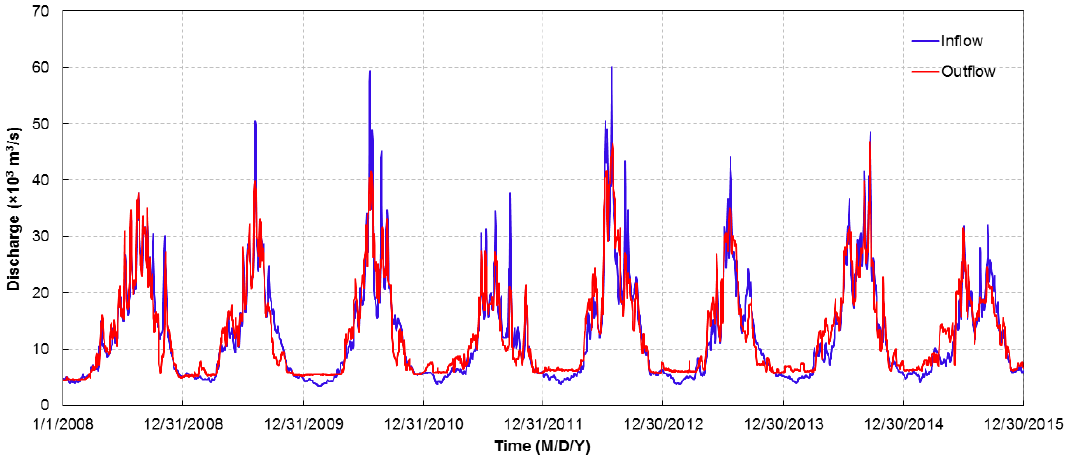
Figure 2. Inflow and outflow process of the Three Gorges Reservoir (TGR) from 2008 to 2015.